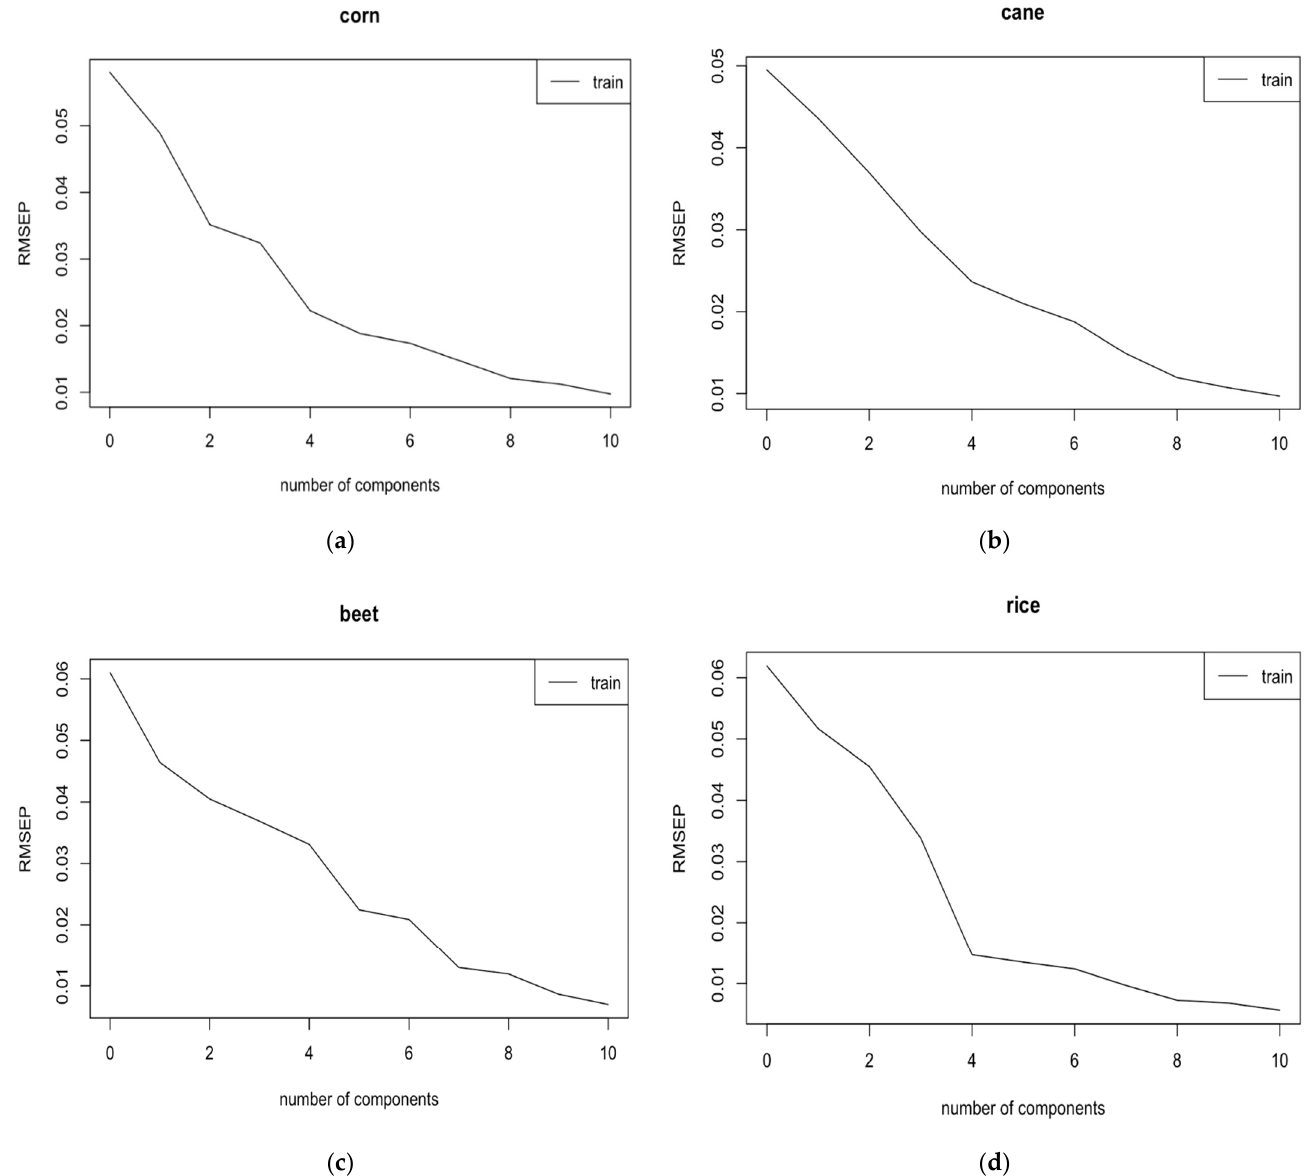
Figure 4. Root mean square error of cross validation (RMSECV) as a function of the number of components for different syrups . (a ) RMSECV as a function of the number of components for corn with 4 factors chosen, ( b ) RMSECV as a function of the number of components for cane with 4 factors selected, ( c ) RMSECV as a function of the number of components for beet with 5 factors selected, ( d ) RMSECV as a function of the number of components for rice with 4 factors chosen.